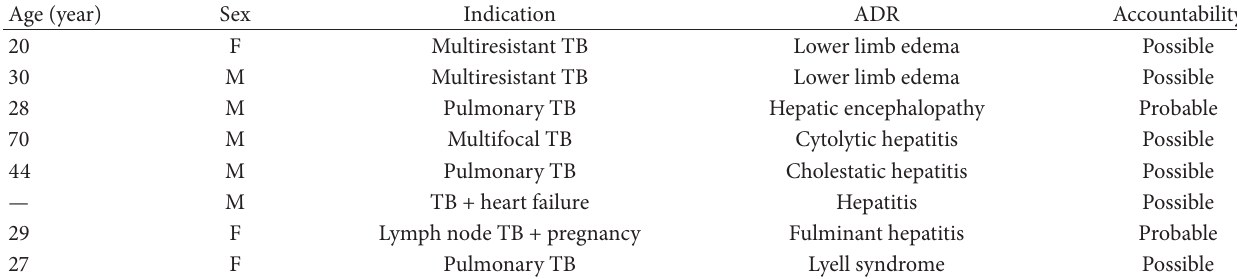
Table 2: Characteristics of eight dead cases.